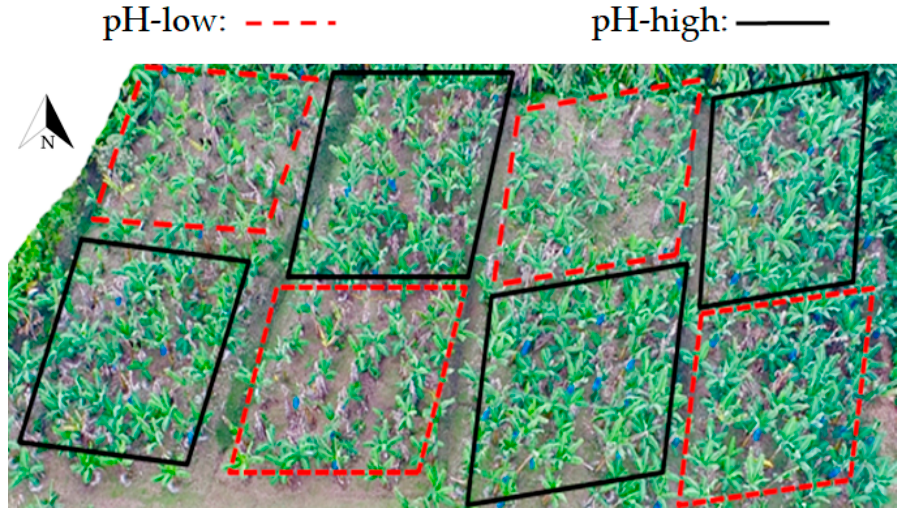
Figure 5. Aerial perspective from 30 m altitude of the impact of soil pH on plant mortality by Fusarium wilt (Foc race 1) of Gros Michel banana in the Exp-east in 28 Millas (Costa Rica) between the 2nd and 3rd crop cycles (aerial photo: Jean-François Michaud, CBC, Radio-Canada) .